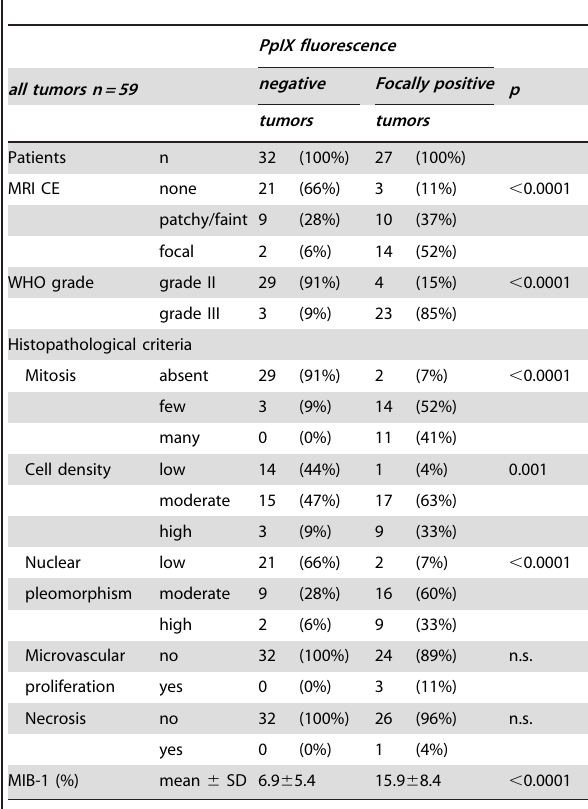
Table 2. All gliomas of the current study (n=59): Assessment of the amount of contrast-enhancement on magnetic resonance imaging, WHO tumor grade, histopathological WHO criteria and proliferation rate in PpIX focally positive versus negative